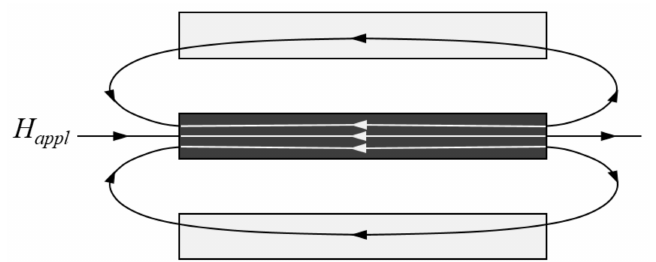
Figure 2. Schematic illustration of the magnetic field of a single strip in the meander-core. The strip is magnetized along the length direction. The magnetic field from the neighboring strips opposes the applied field inside the strip as seen by the white field lines, which will result in a decrease in the internal magnetic